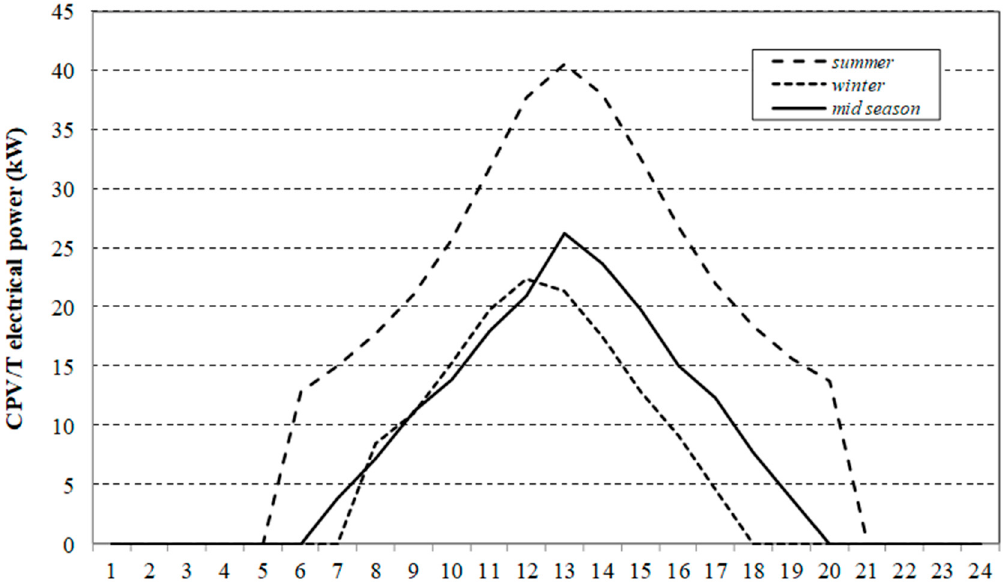
Figure 6. Electrical production of the CPV / T system in the summer, winter, and middle seasons.